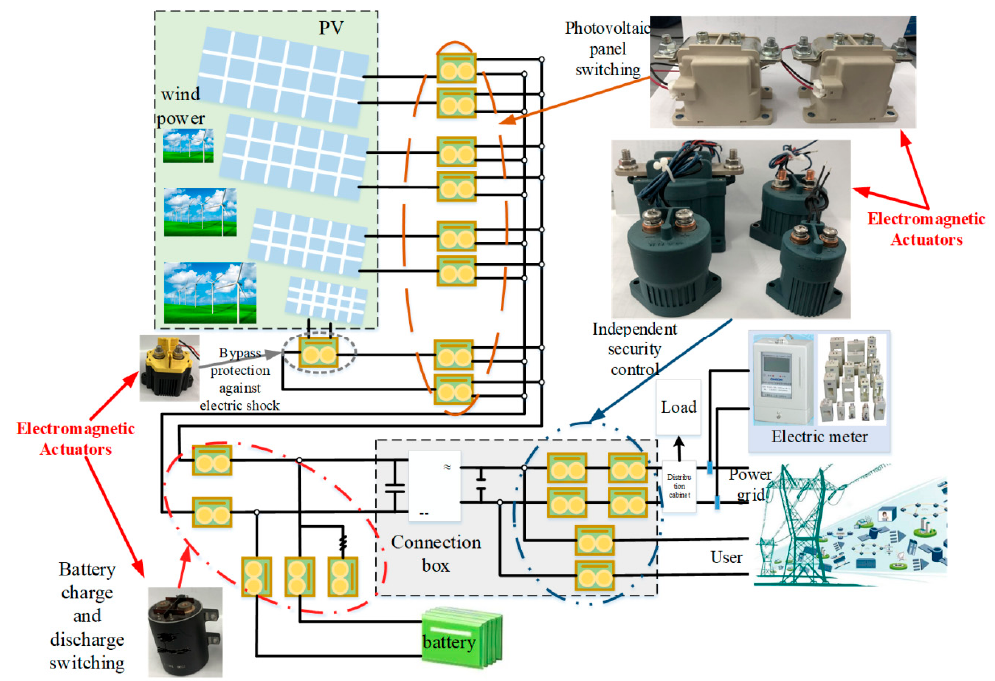
Figure 1. Application of electromagnetic actuators in renewable energy system.